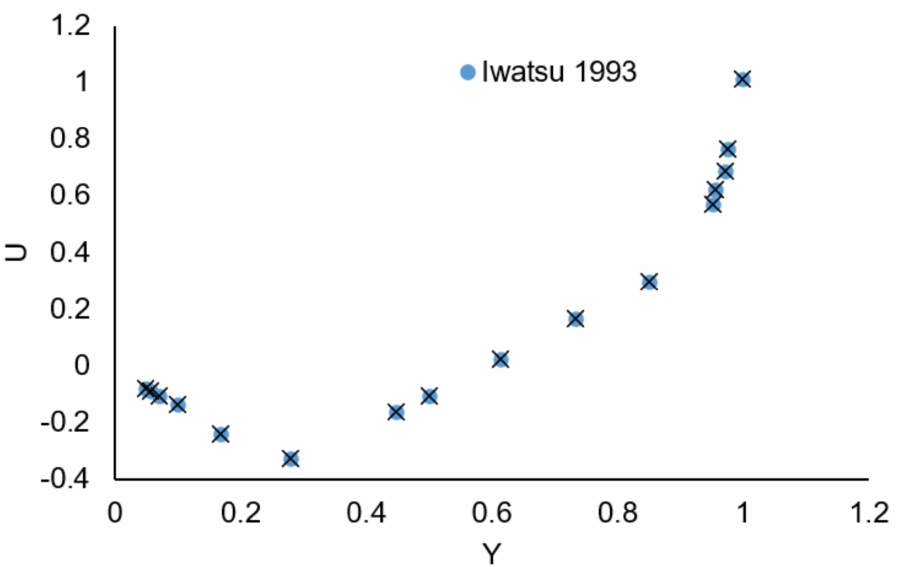
Figure 2. Comparison of present work with the work of Iwatsu et al. [49].